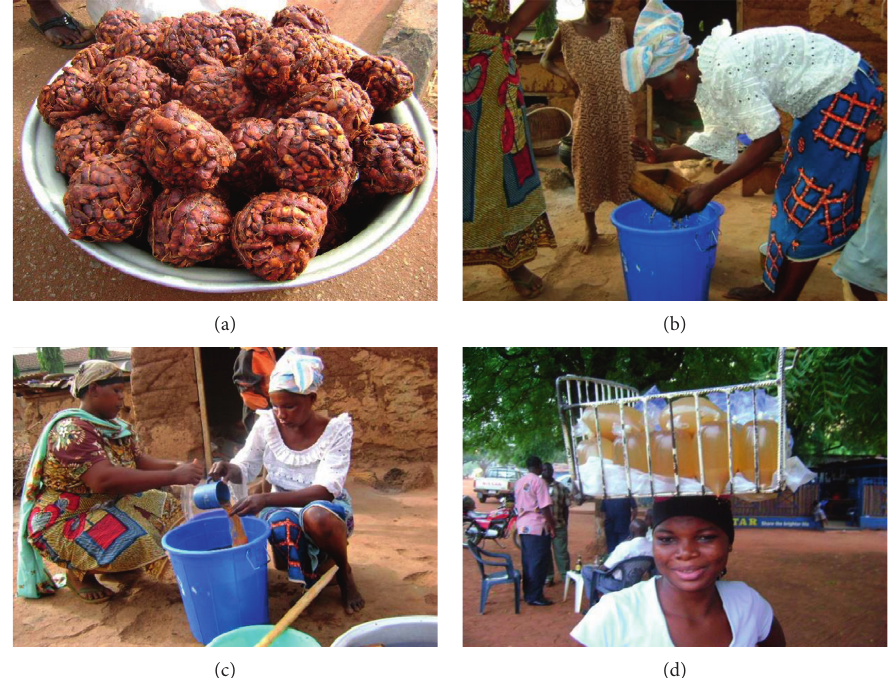
Figure 2: Brewing: Poha Beer production process. Moulded tamarind fruits are shown in (a), while the sieving process is shown in (b). Poha Beer bagging and the bagged and chilled products for sale are, respectively, shown in (c) and